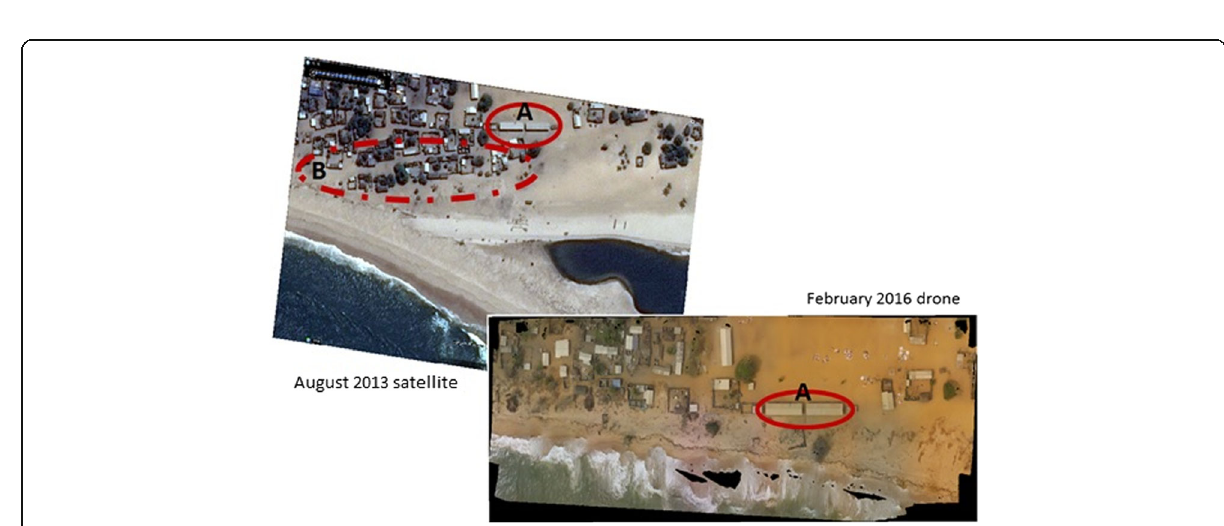
Fig. 6 Satellite and drone images of Fuvemeh in 2013 and 2016 showing location of the school building ( a ) and the area eroded ( b